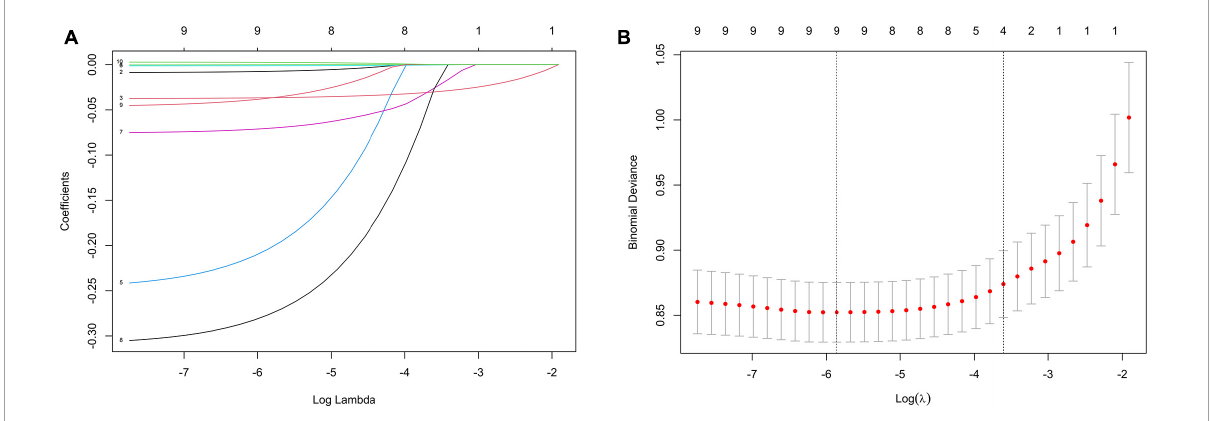
FIGURE1 Feature selection by LASSO. (A) LASSO coefficient profiles ( y -axis) of the nine features. The upper x-axis shows the average numbers of predictors and the lower x -axis shows the log( λ ). (B) Ten-fold cross-validation for tuning parameter selection in the LASSO